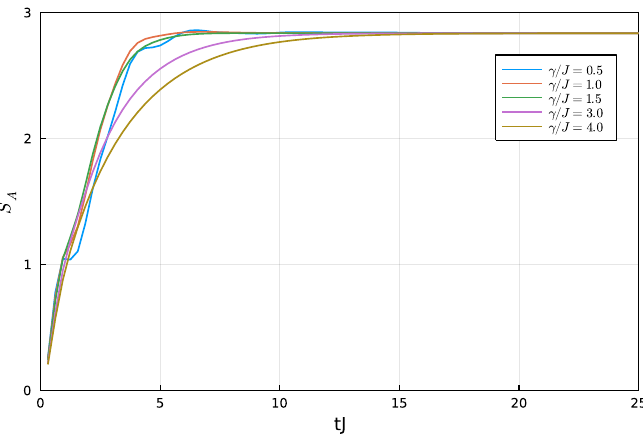
as a function of tJ . γ is the A = 3, and subsystem b